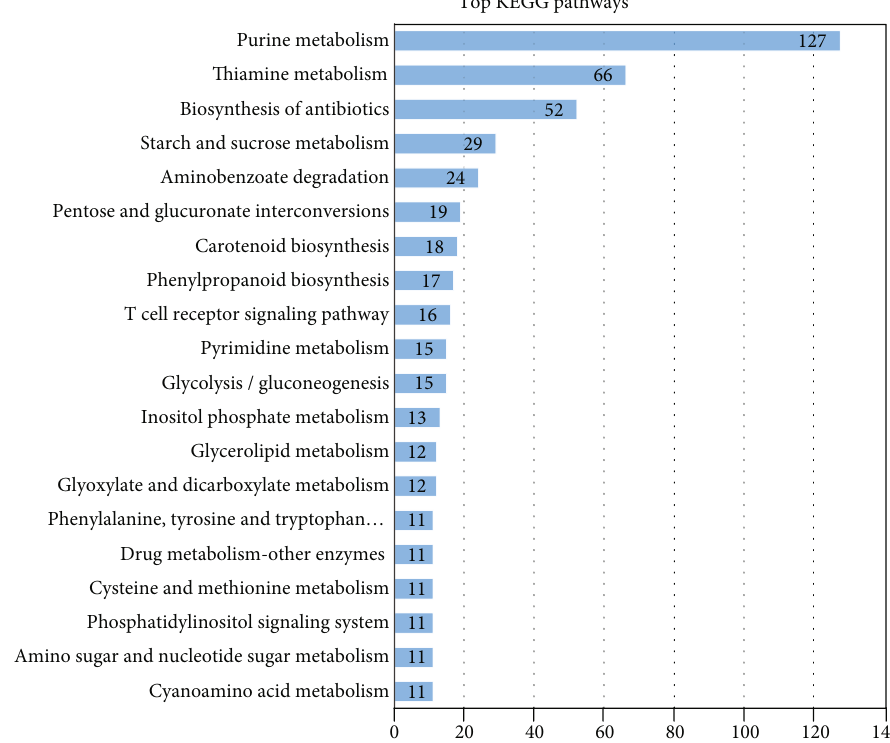
Figure 8: The top 20 KEGG pathways assignments in heat stress-responsive downregulated unigenes. The number of unigenes predicted to belong to each category is shown.